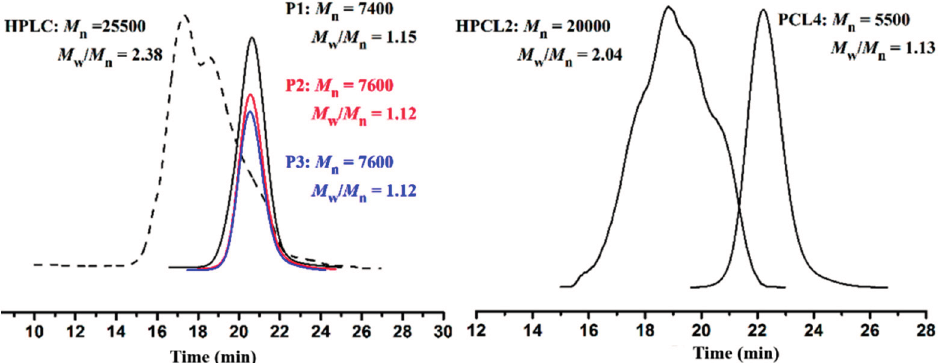
Figure 3. The GPC curves of the linear poly( ε -caprolactone) (P1, M n GPC = 7400 g/mol, M w / M n = 1.15; PCL4, M n GPC = 5500 g/mol, M w / M n = 1.13), hyperbranched poly( ε -caprolactone)